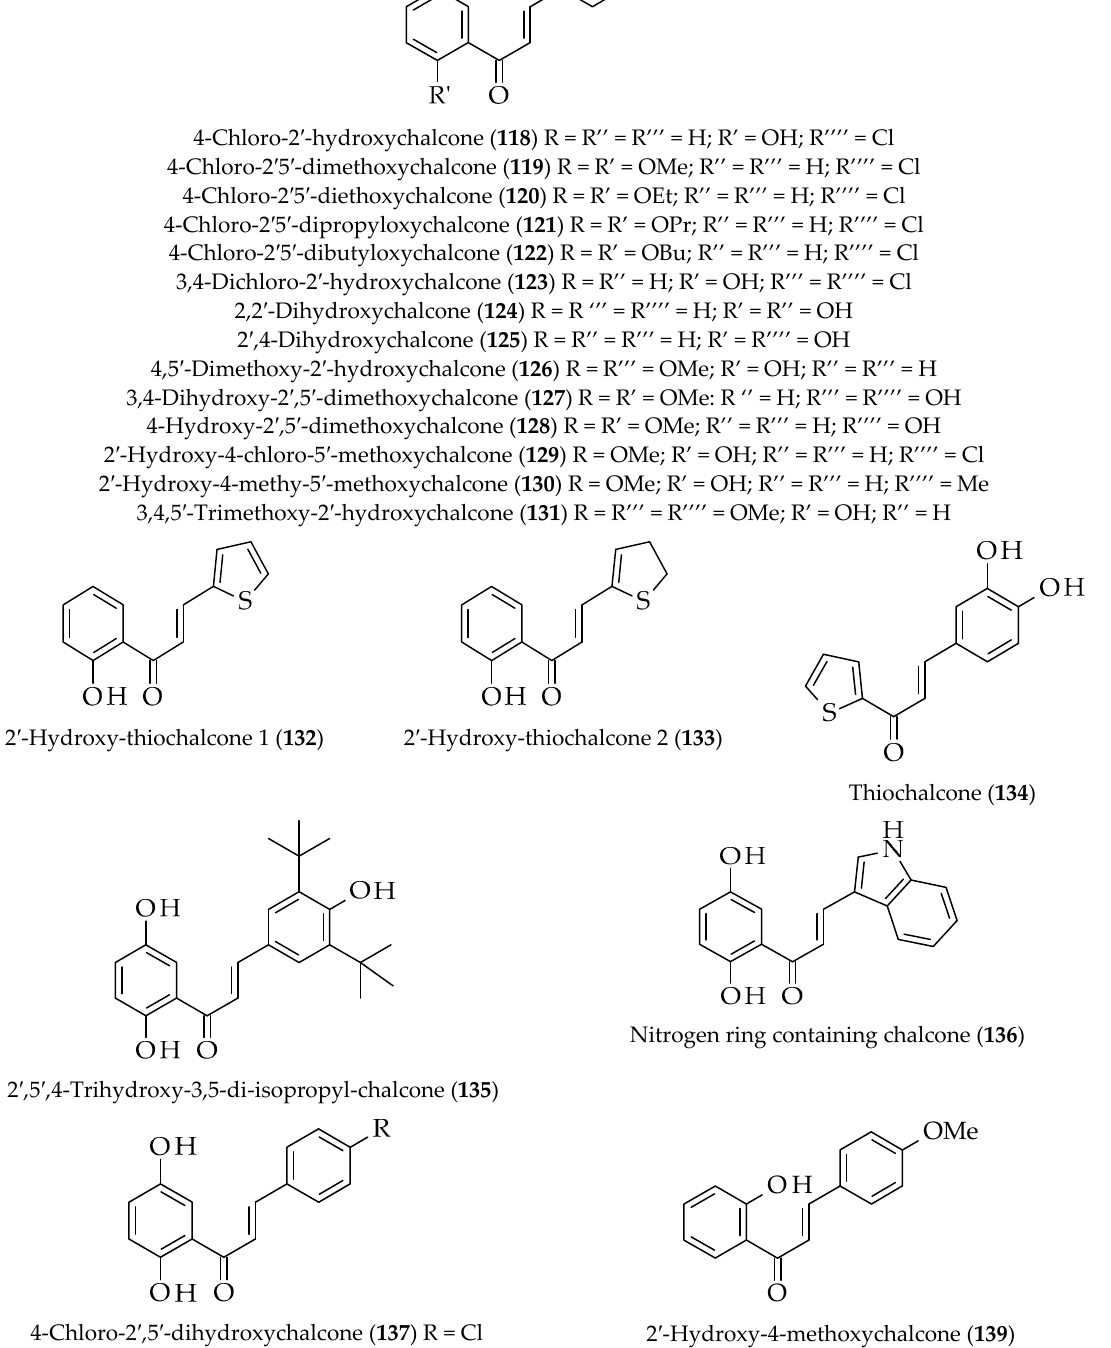
Figure 13. Structures of some synthetic anti-inflammatory chalcones.